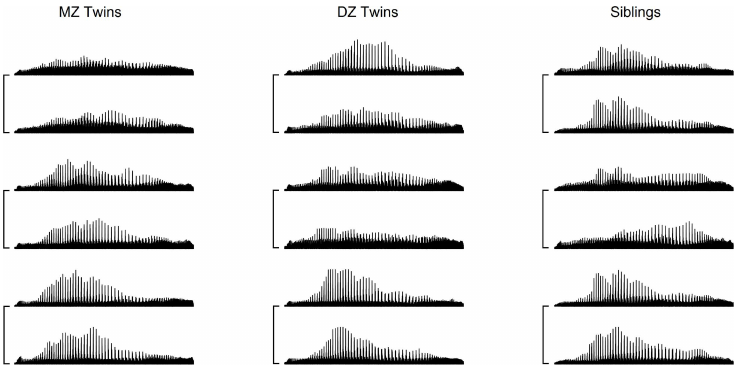
Fig 6. The local connectome fingerprints of monozygotic (MZ) twins, dizygotic (DZ) twins, and non- twin siblings. Three pairs of connectome fingerprints are shown for each group, Pairs are annotatedby a connecting line. The connectomefingerprints between MZ twins show the grossly similar patterns though some between-subject difference can still be observed. DZ twins and siblings also have a similar pattern, but the between-subject difference becomes more